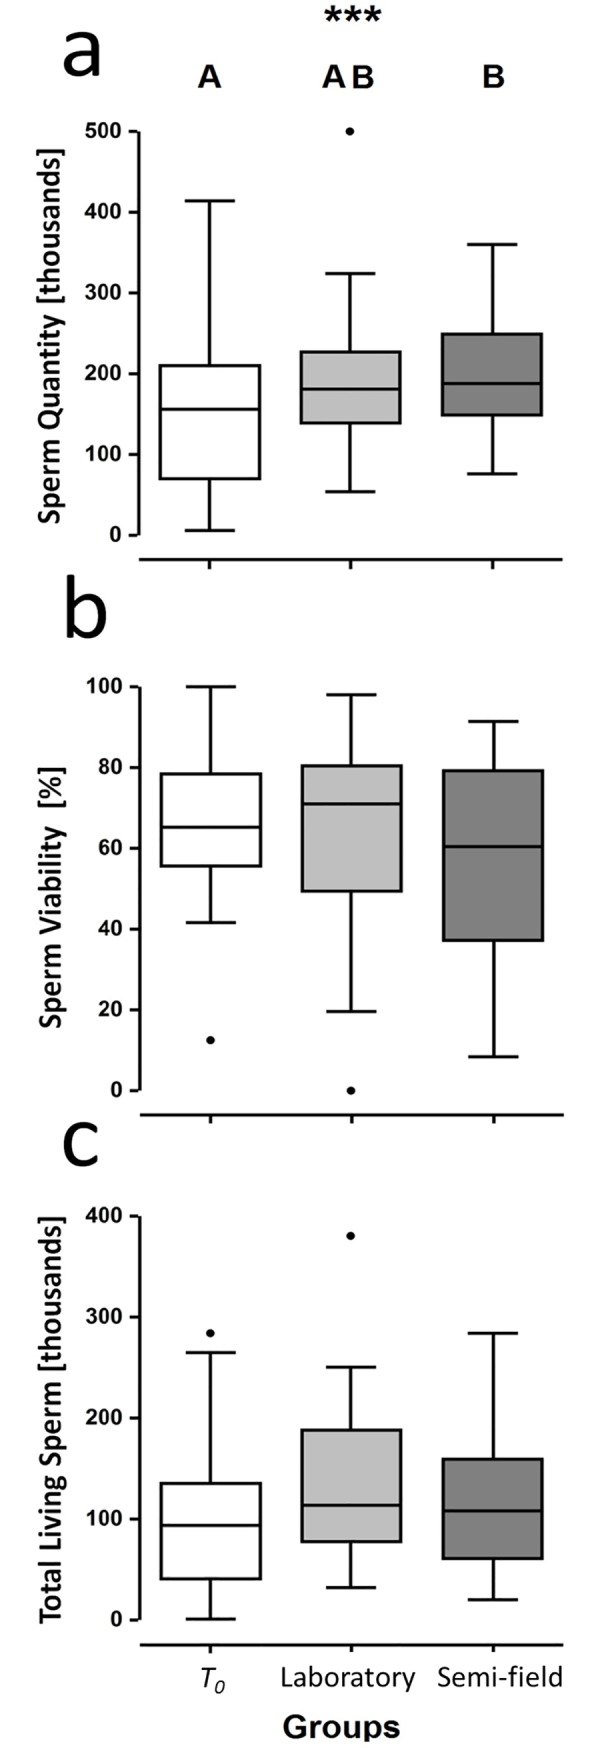
Sperm traits of male Osmia cornuta: (a)
sperm quantity, (b) percentage of viable and
(c) quantity of living sperm immediately post emergence
(T0), four days post laboratory
conditions (Laboratory) and four days post semi-field conditions
(Semi-field). Significant differences among groups (p < 0.001) are
indicated by different letters (A, B).